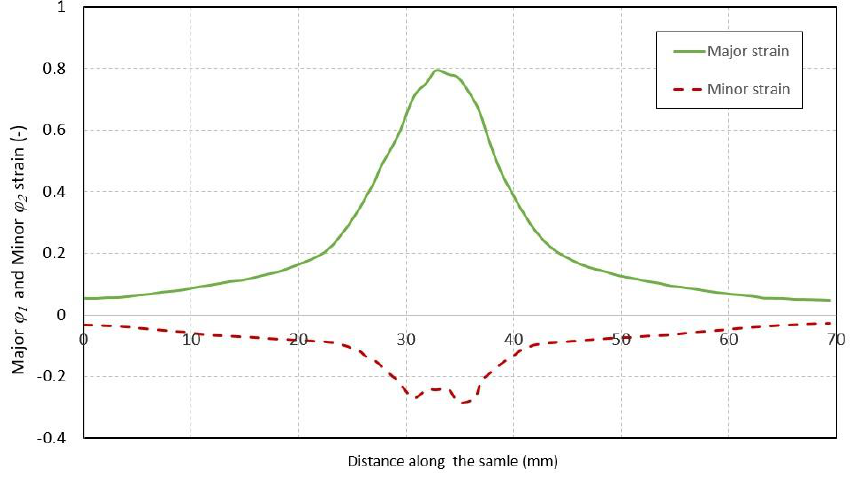
Figure 6. Dependence of the major and the minor strain on distance along the sample.